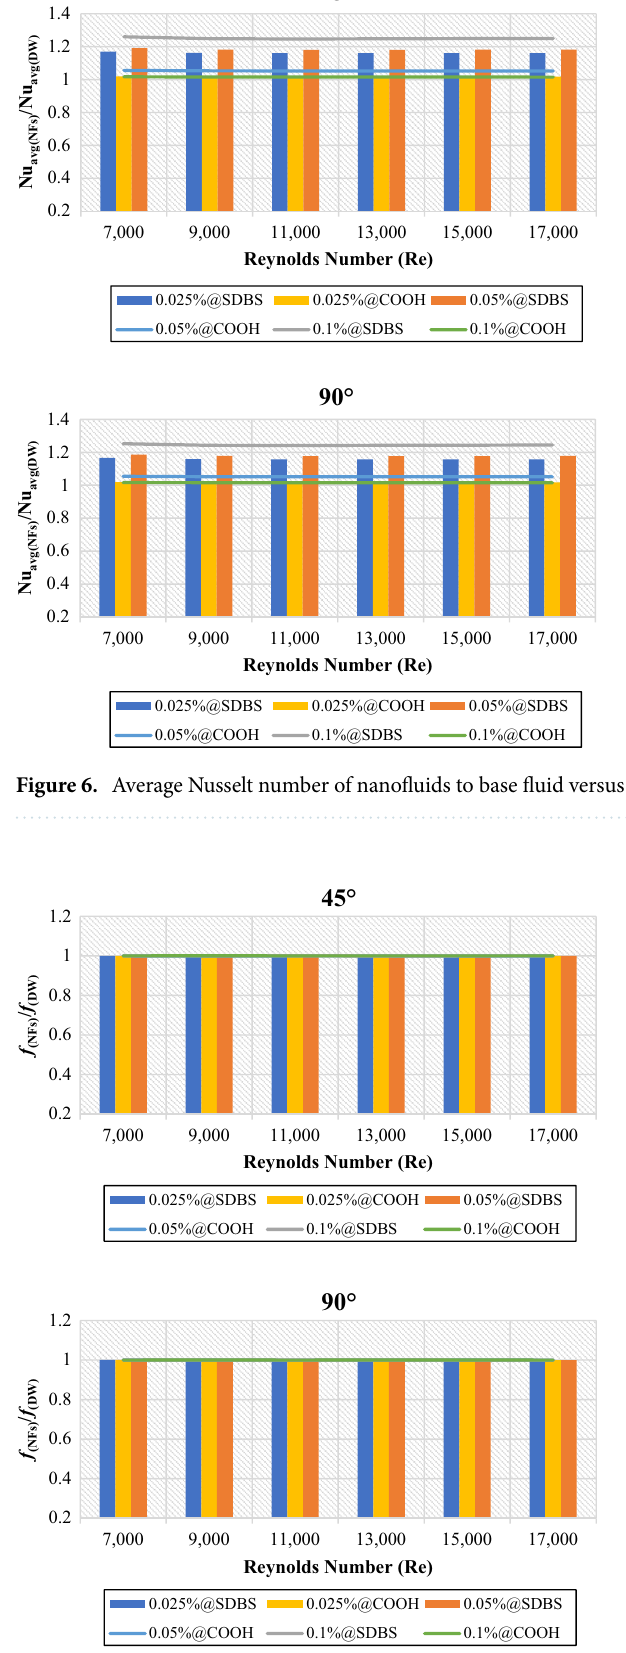
Figure 7. Friction factor of nanofluids to base fluid versus Reynolds numbers for 45° and 90°